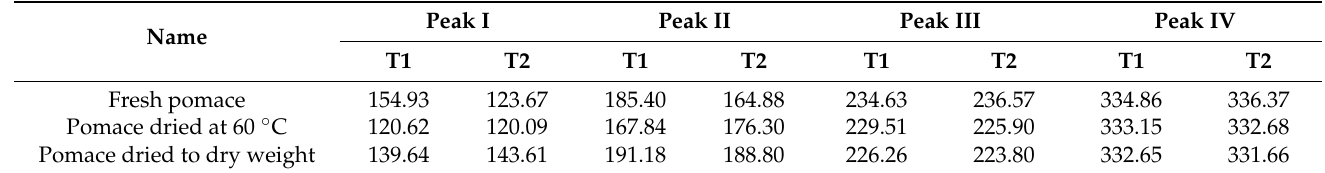
Table 3. Peak maximum temperatures ( ◦ C) for apple-pomace samples based on the obtained DSC curves. Analysis under nitrogen atmosphere.